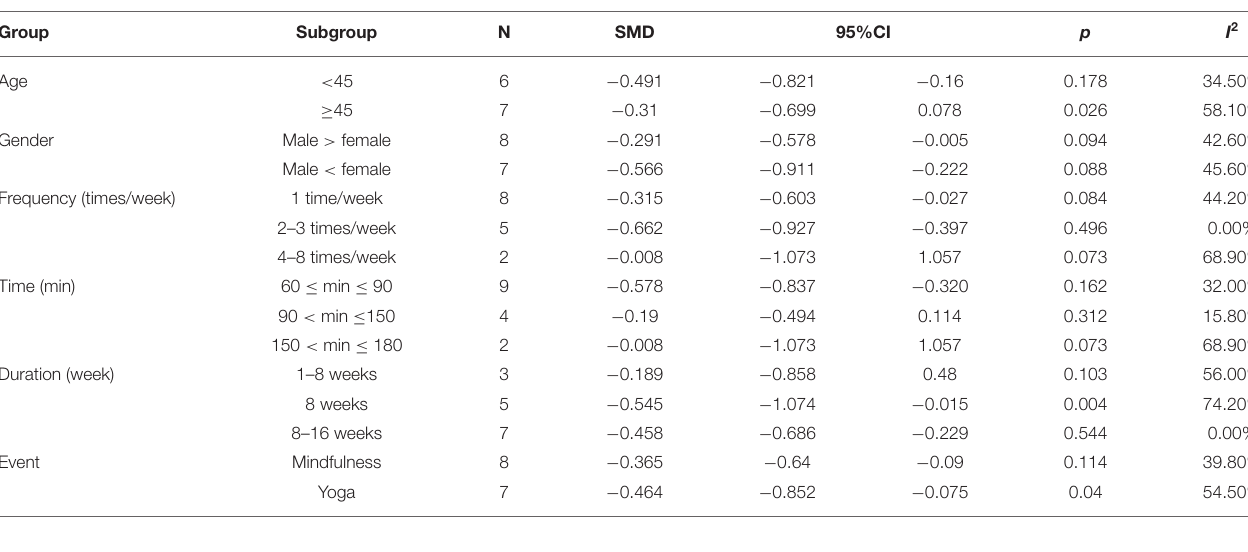
TABLE 4 | Subgroup analysis of PTSD symptoms.